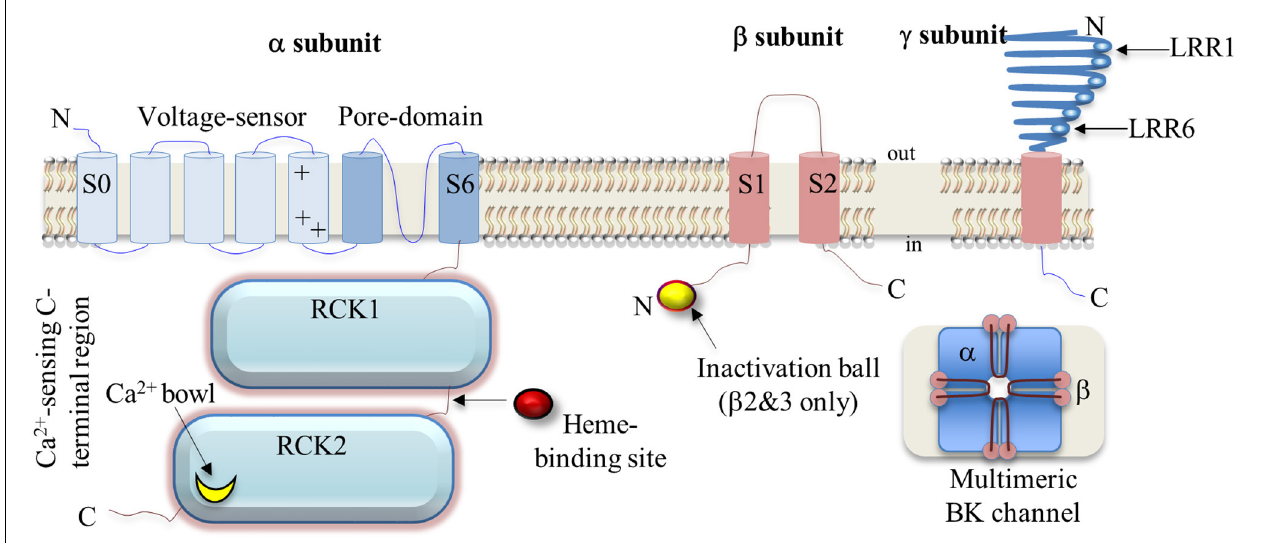
FIGURE 1 | A schematic illustration of BK channel α , β and γ subunit architecture with major structures defined. Abbreviations: N, amino-terminus; C, carboxy-terminus; LRR, leucine-rich repeat; S, transmembrane segment; RCK, regulator of K + conductance.